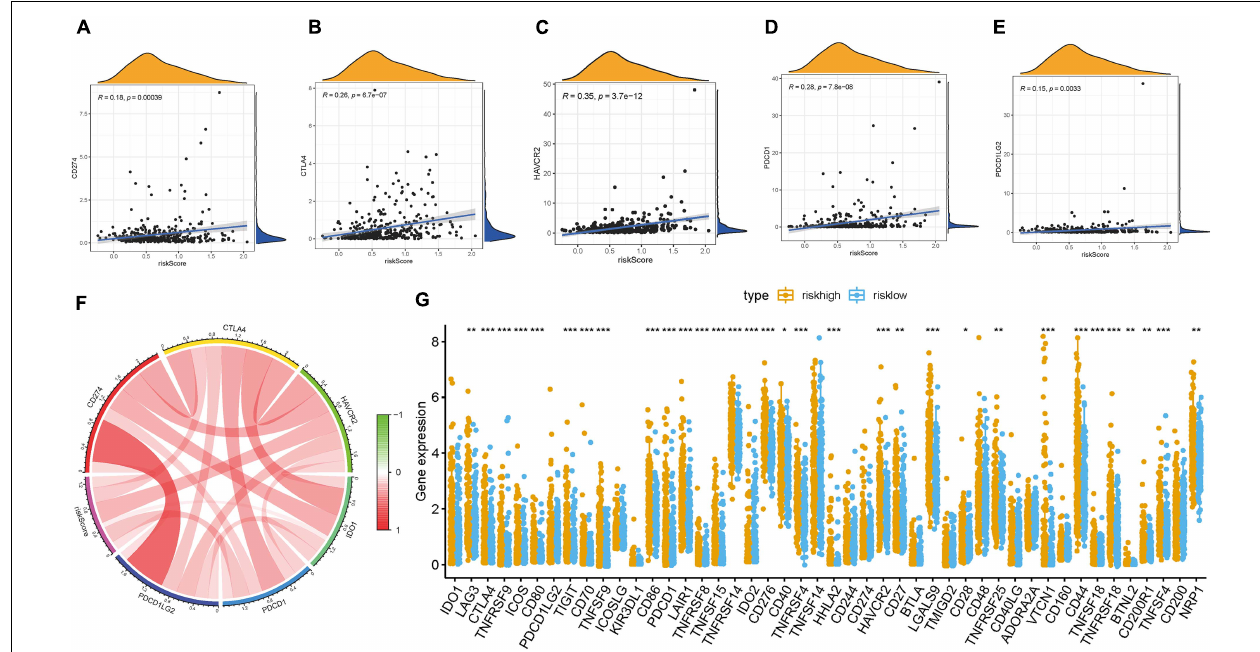
FIGURE 7 | Correlation between prognostic risk signature with hub immune checkpoint genes. (A) Correlation between prognostic risk signature and CD274. (B) Correlation between prognostic risk signature and CTLA4. (C) Correlation between prognostic risk signature and HAVCR2. (D) Correlation between prognostic risk signature and PDCD1. (E) Correlation between prognostic risk signature and PDCD1LG2. (F) Correlation analysis between immune checkpoint inhibitors (CD274, PDCD1, PDCD1LG2, CTLA4, HAVCR2, and IDO1) with prognostic risk signature. (G) Differences in expression of 47 immune checkpoint blockade genes between low- and high-risk score groups in the TCGA-LIHC cohort. The asterisks represented the statistical p value (* P < 0.05; ** P < 0.01; *** P <